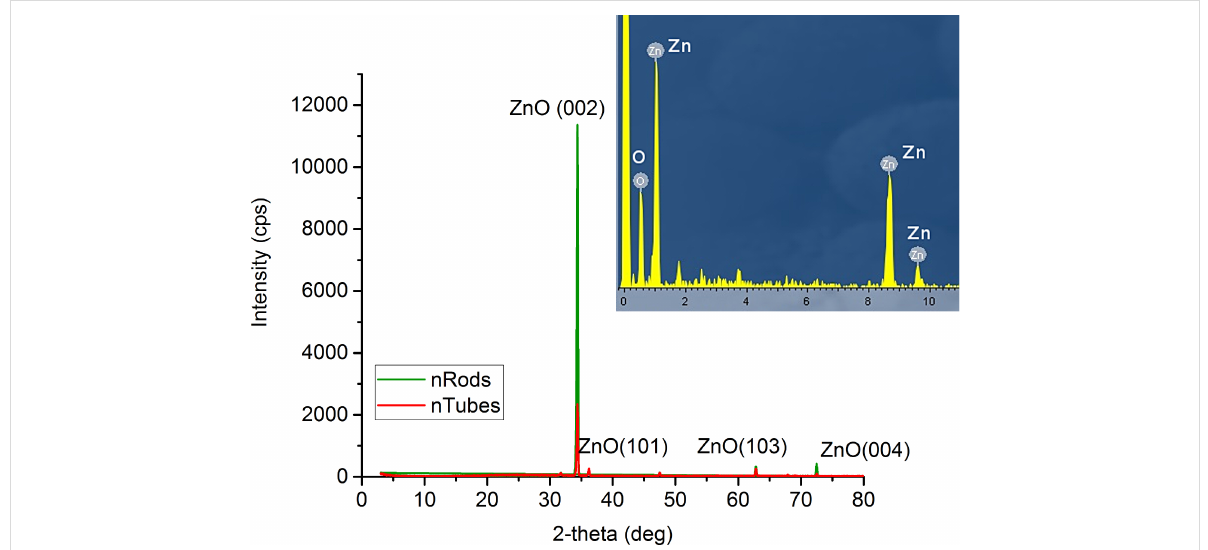
Figure 3: XRD pattern of ZnO nanorod and nanotube arrays. Inset: EDS spectrum of the as-synthesized samples.